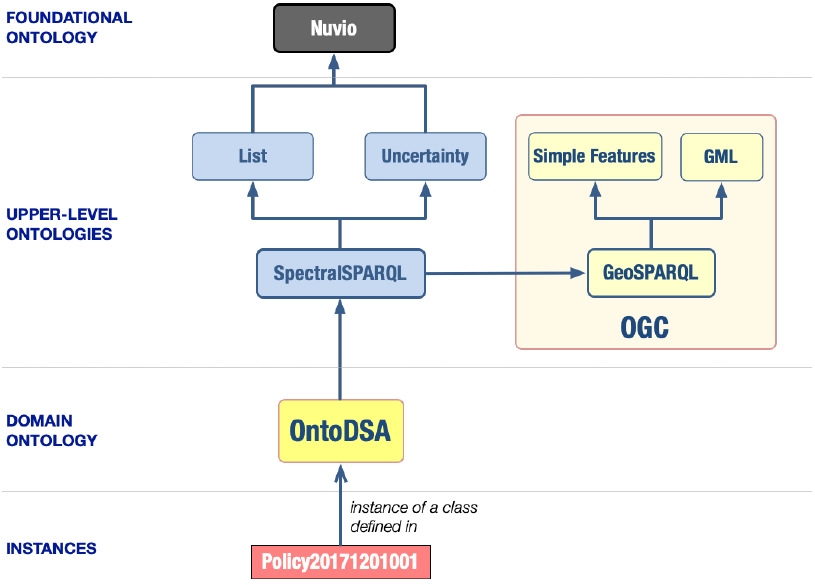
Figure 6. The Architecture of the DSA